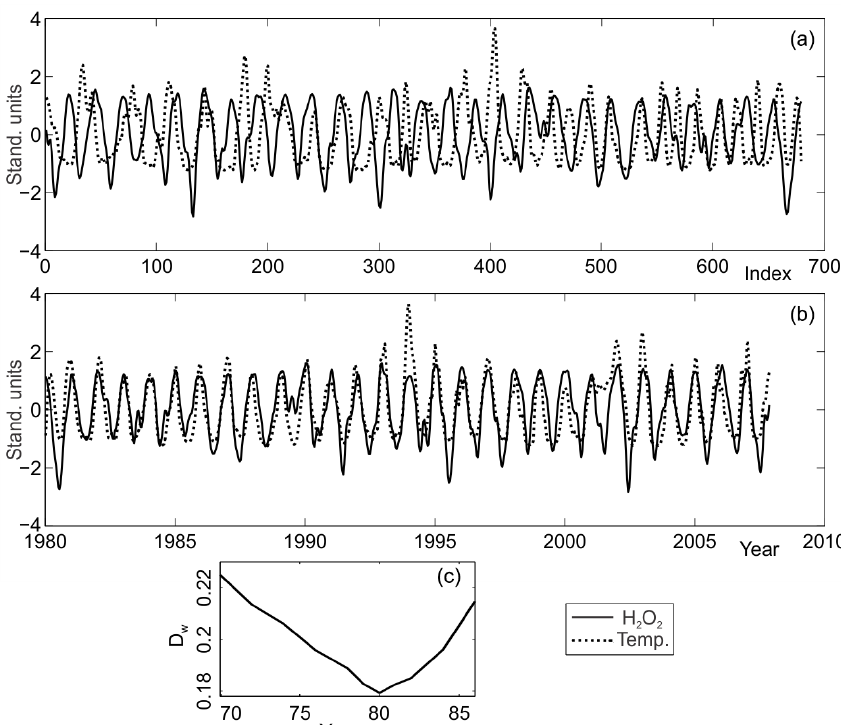
Figure 4. Panel (a) shows the unwrapped (cid:98) C and (cid:98) T series in standardised ordinates, with the index i = 0 corresponding to the mouth of the core. Panel (b) shows the two warped series with their abscissas i mapped back to time, expressed in years beginning on 1 January 1980: T , C (t) . In both panels, (cid:98) C is shown as a dotted curve and (cid:98) T is shown as a solid curve, with ordinates in arbitrary units. Panel (c) shows the behaviour of distance D w for the year we have performed the